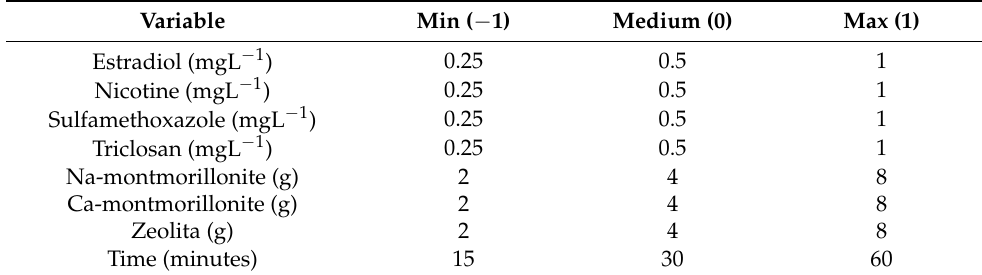
Table 3. Variables and levels of the applied experimental